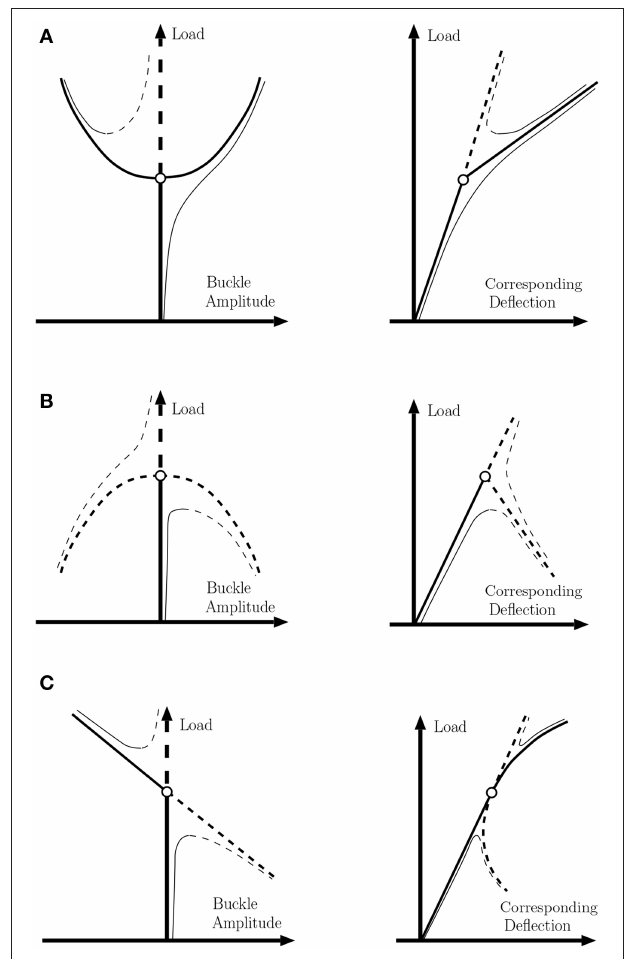
FIGURE 1 | (A) Supercritical, (B) subcritical, and (C) transcritical buckling instabilities and their unfolding in the presence of small symmetry-breaking effects. Heavy lines: perfect system. Light lines: imperfect system. Solid lines: stable. Broken lines: unstable under controlled